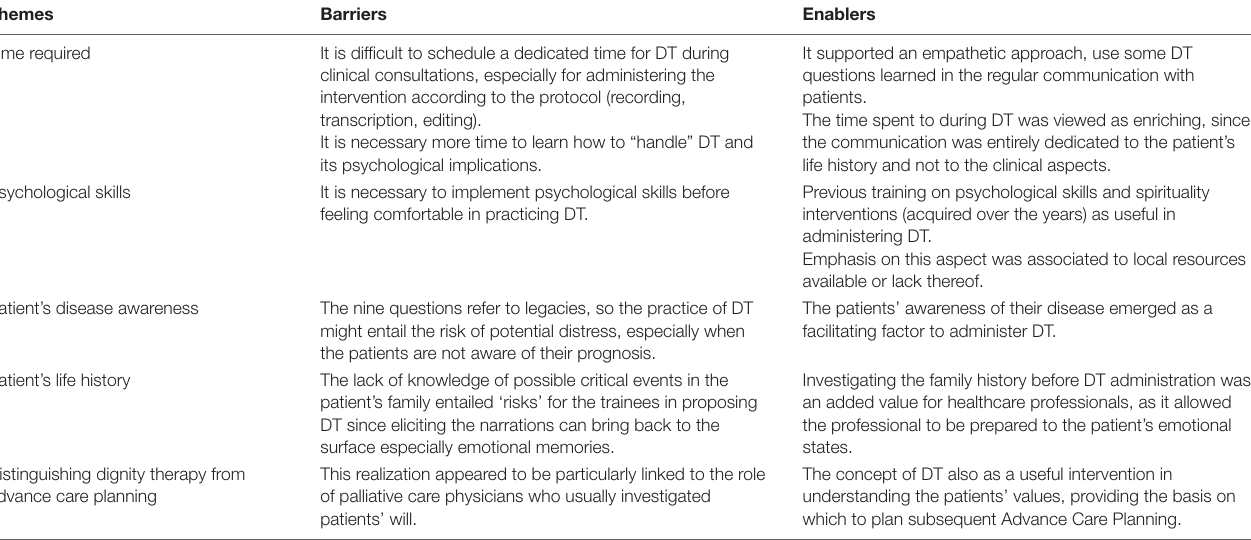
TABLE 3 | Summary of the